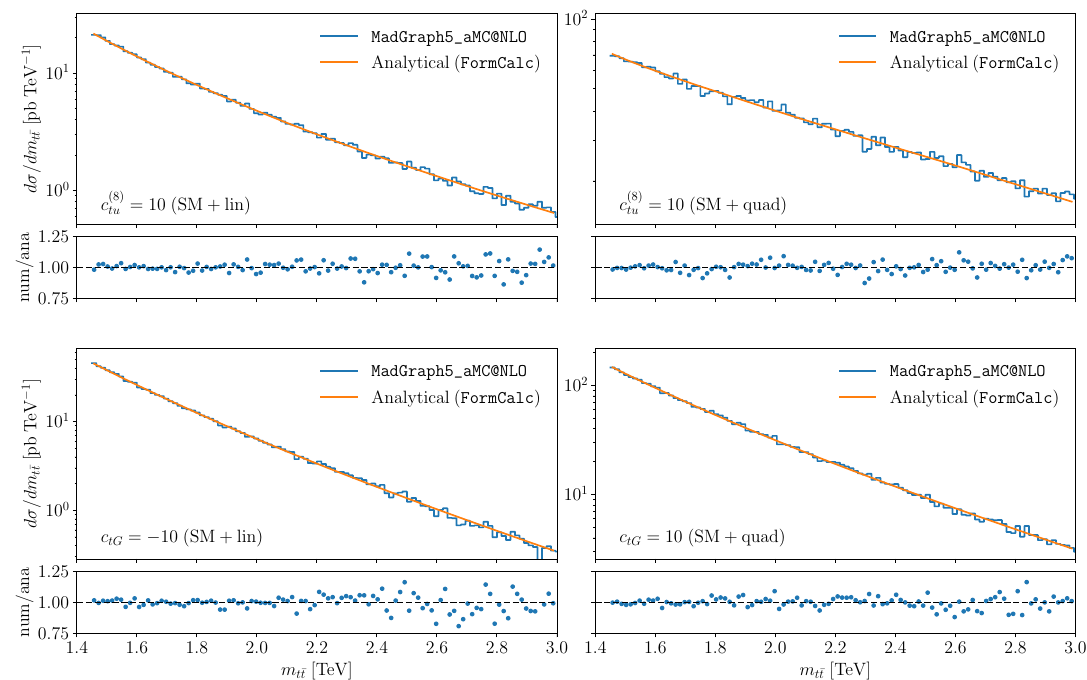
Figure 4. Parton level m distribution in the analytical calculation of top-quark pair production t ¯ t at LO based on the pipeline of figure 3 compared with the corresponding numerical simulations based on MadGraph5_aMC@NLO . We display the SM predictions and those of the SMEFT for non-zero values of the c tG and c (8) coefficients in the linear-only and quadratic-only cases. The tu bottom panels display the ratio between the numerical and analytical